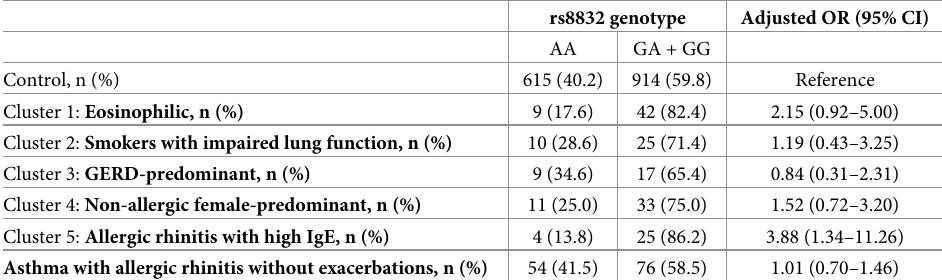
Table 3. Association of the IL4RA polymorphism with the exacerbation